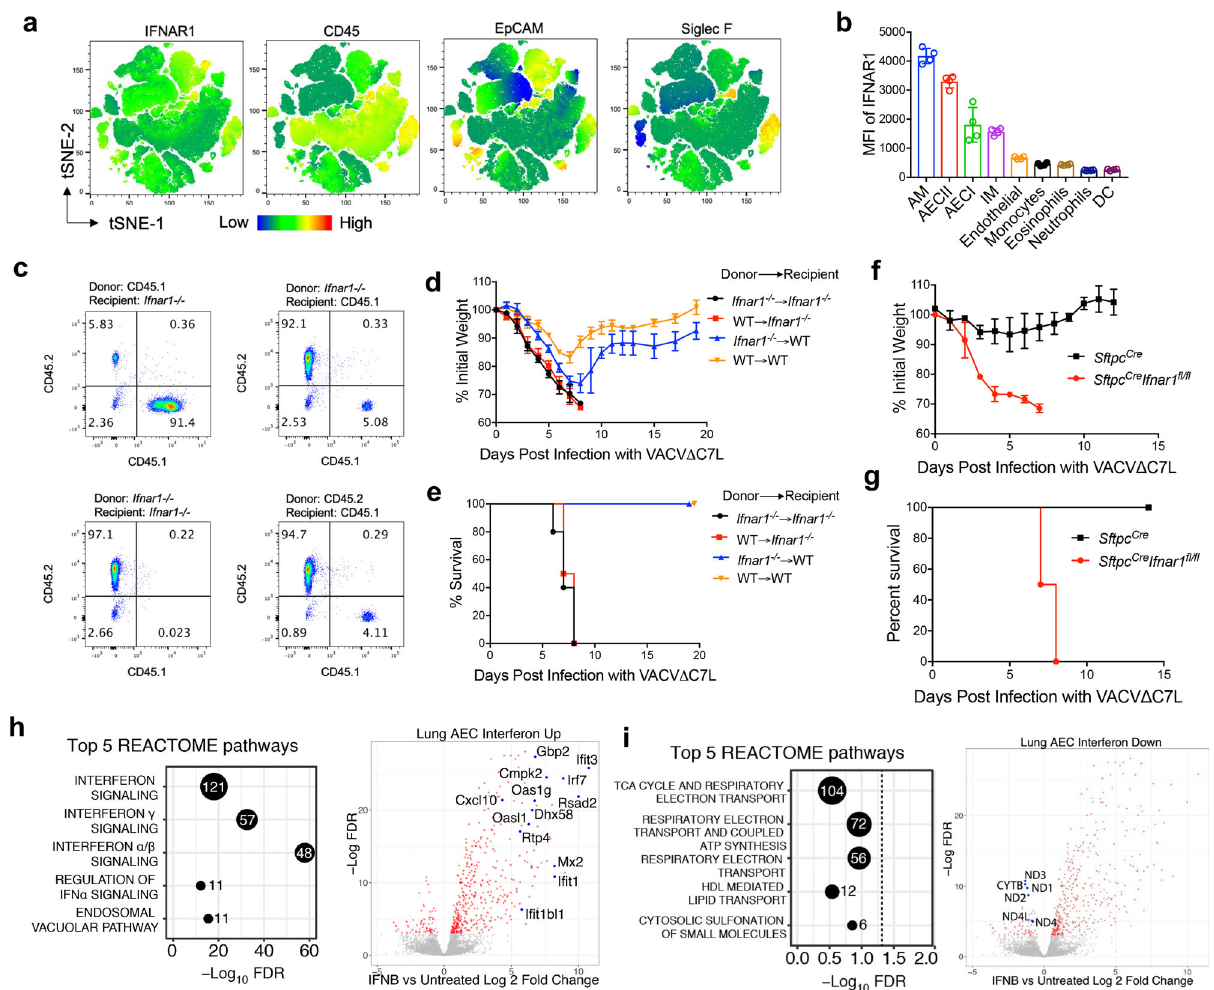
Fig. 4 Type I IFN signaling in lung AECIIs plays a crucial function in host restriction of vaccinia infection. a , b FACS analysis of IFNAR1 expression in different cell populations from lungs in C57BL/6J mice. a t-SNE analysis showing different cellular markers-IFNAR1, CD45, EpCAM and Siglec F expression in different cell populations from lungs. (b) MFI of IFNAR1 expression in different cell populations from lungs. c shown are the reconstitution ef fi ciency in bone marrow chimeras ( Ifnar1 − / − → Ifnar1 − / − , WT → WT, Ifnar1 − / − → WT, and WT → Ifnar1 − / − ). d , e shown are the percentages of initial weight d or Kaplan – Meier survival curve e over days post intranasal infection with VACV Δ C7L at 2 × 10 7 pfu in bone marrow chimeras ( Ifnar1 − / − → Ifnar1 − / − , WT → WT, Ifnar1 − / − → WT, and WT → Ifnar1 − / − ) ( n = 5 in each group). f , g shown are the percentages of initial weight f or Kaplan-Meier survival g over days post intranasal infection with VACV Δ C7L at 2 × 10 7 pfu in Sftpc cre Ifnar1 fl / fl and Sftpc cre mice after treatment of tamoxifen ( n = 5 in each group). h , i Signi fi cance dotplots and volcano plots depicting top differentially expressed pathways (left) and genes (right), respectively, between naïve and IFN- β (500 U/ml) treated AECII cells from C57BL/6J mice. Dashed line indicates a false discovery rate cutoff of 0.05. Differentially expressed genes are highlighted in red. Data are presented as mean ± SD. Data are representative of one h , i or two a – g independent experiments. Source data are provided as a Source Data fi